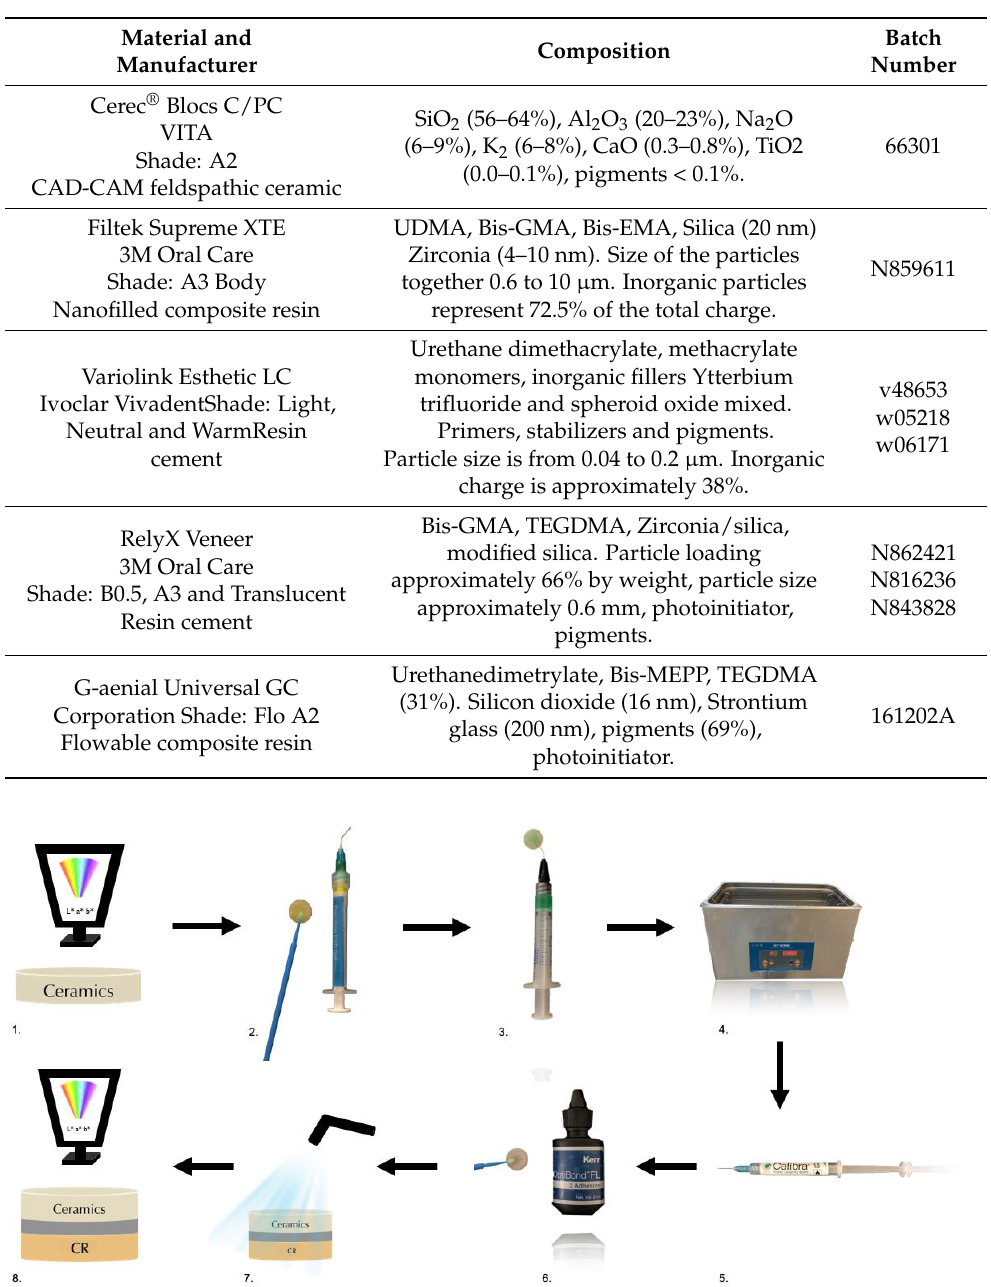
Table 1. Manufacturers and compositions of ceramics, resin-based materials and luting agents studied.